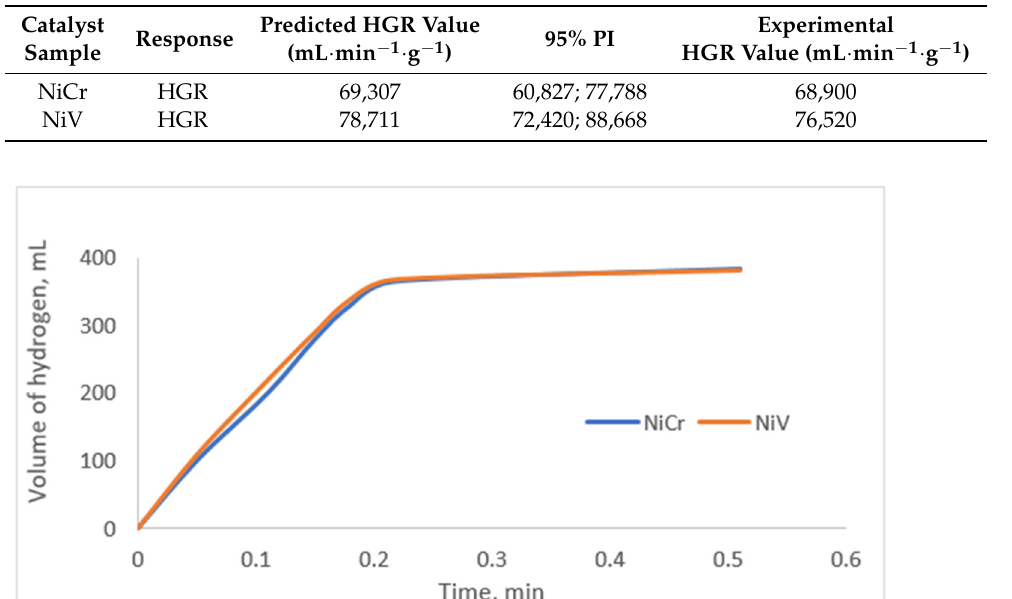
Figure 6. Contour plots of HGR for ( a ) NiCr system and ( b ) NiV system.